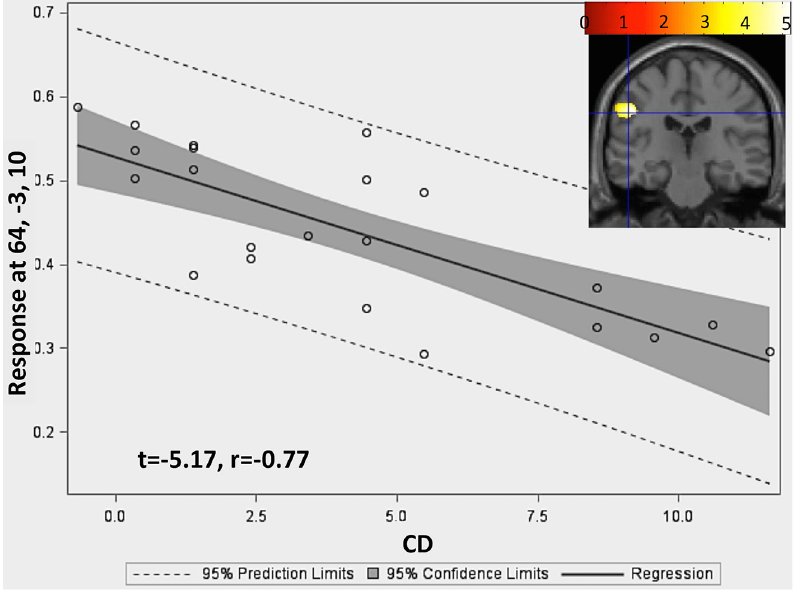
Fig 4. Whole brain regression analyses with conduct disorder symptom count within patients. Color map (Y coordinate: -25 mm) showing negative association between the left somatosensory and motor cortex region (i.e. precentral and postcentral gyrus (BA 1, 2, 3 and 4)) and supramarginal gyrus and inferior parietal lobule (BA 40)) and BD score in patients after co-varying for age and IQ. The crosshair marks the voxel with maximum association and the regression plots below the color map shows the association between the region and conduct disorder symptom count Z-score for that voxel with maximum association. Rt = Right.